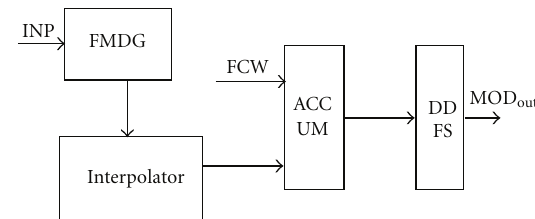
Figure 1: Block diagram of digital FM modulator.